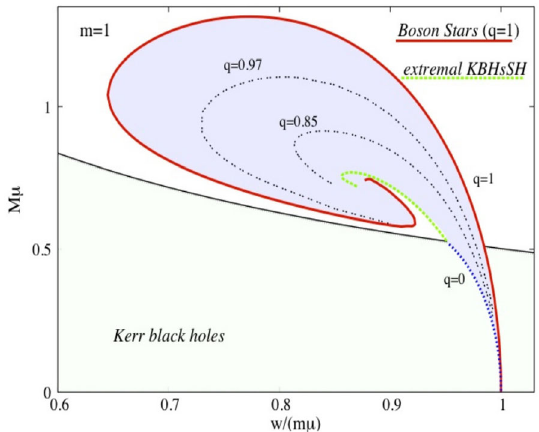
scalar fi eld frequency. Solutions for a range of values of q interpolating between Kerr ( q ¼ 0) and BSs ( q ¼ 1) all with azimuthal quantum number m ¼ 1. For 0 \ q \ 1, solutions describe rotating BHs surrounded by a scalar cloud, constituting scalar hair for the